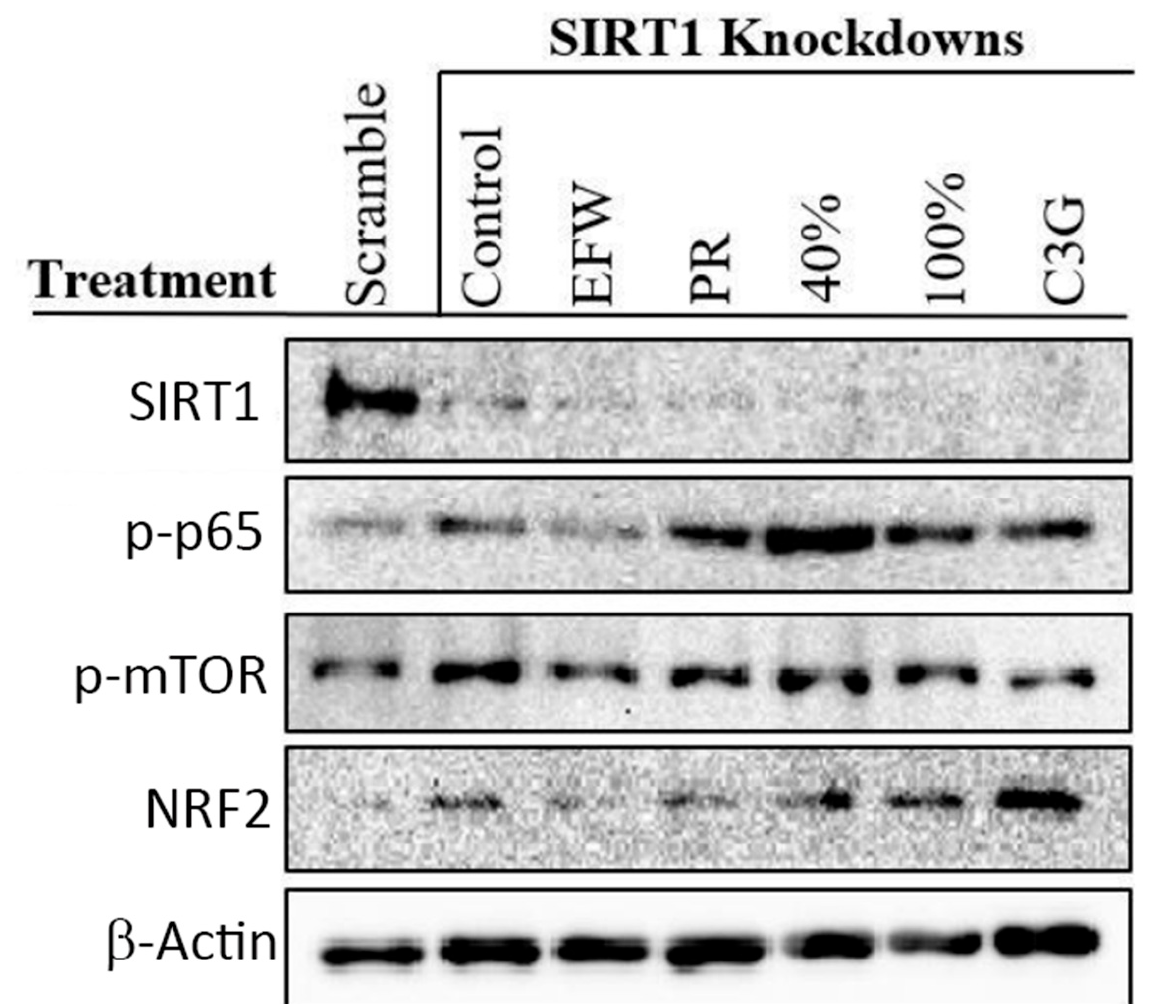
Figure 6. Knockdown of SIRT1 Inhibits Haskap Phenolic-Mediated Changes p-p65 and p-mTOR Levels but not NRF2 Protein Levels. 2DD cells were exposed to phenolic fractions for 72 h following siRNA-mediated knockdown of SIRT1. Equivalent whole cell protein lysates were blotted for SIRT1 (top row), p-p65 (2nd row), p-mTOR (3rd row) and NRF2 (4th row). β -actin was used as a load control and served a baseline for quantification.